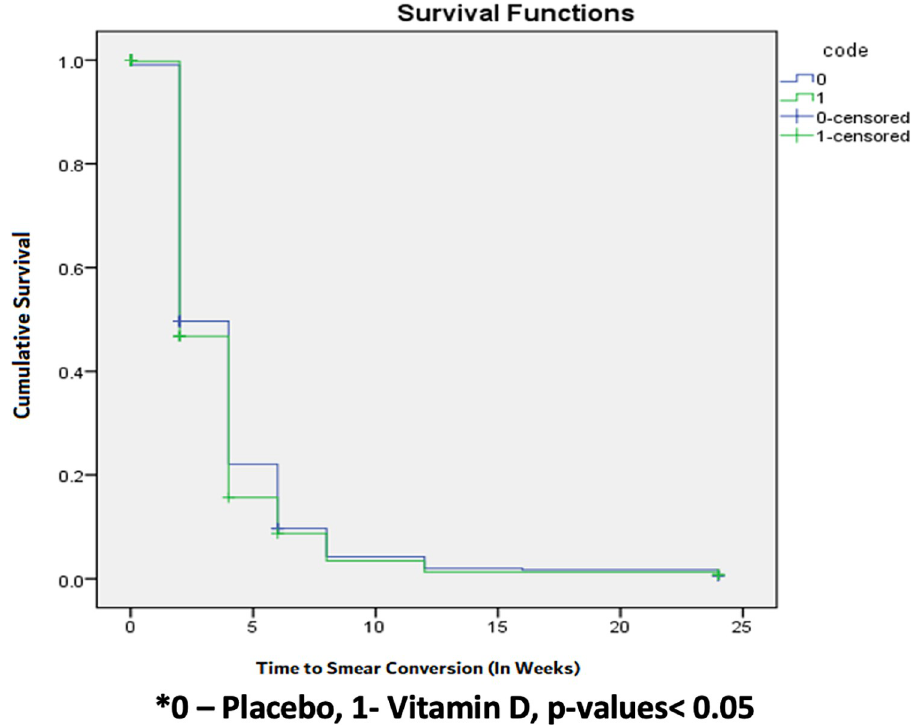
Fig 3. Kaplan Meier graph presenting time to sputum smear conversion in both the groups. Shows time to conversion of sputum smear in both vitamin D and placebo groups. There is no significant difference in the time to sputum smear conversion between the two groups (p =